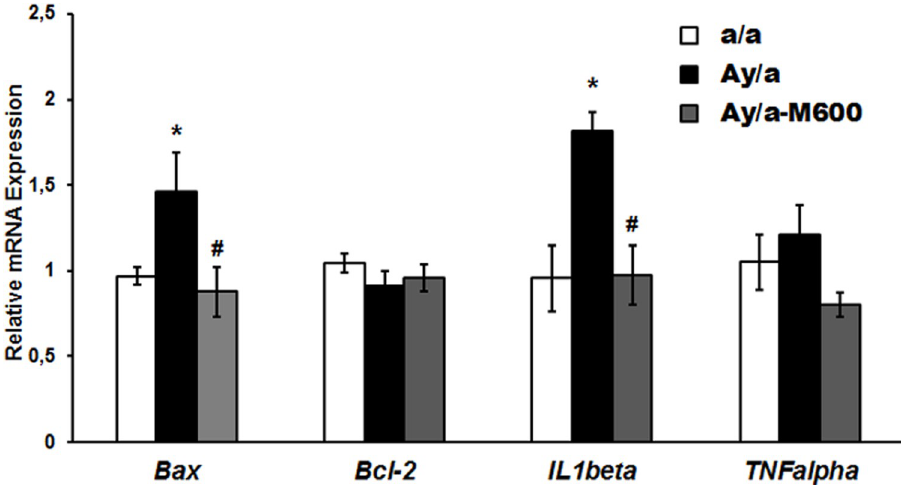
Fig 3. The gene expression of the proteins involved in apoptosis and inflammation in the liver of obese agouti- mice and the effect of metformin treatment. The levels of mRNA expression of the Bax , Bcl-2 , IL1beta and TNFalpha genes encoding pro-apoptotic factor Bax, anti-apoptotic factor Bcl-2, the inflammatory cytokines interleukin 1 β and TNF α are normalized by the expression of the reference 18s rRNA gene. The relative mRNA expression is calculated with the respect to control group. The data are presented as the M ± SEM , n = 5. � —the difference between the Groups a/a and Ay/a-M600 is significant at the P < 0.05, #—the difference between the Groups Ay/a and Ay/a-M600 is significant at the P <